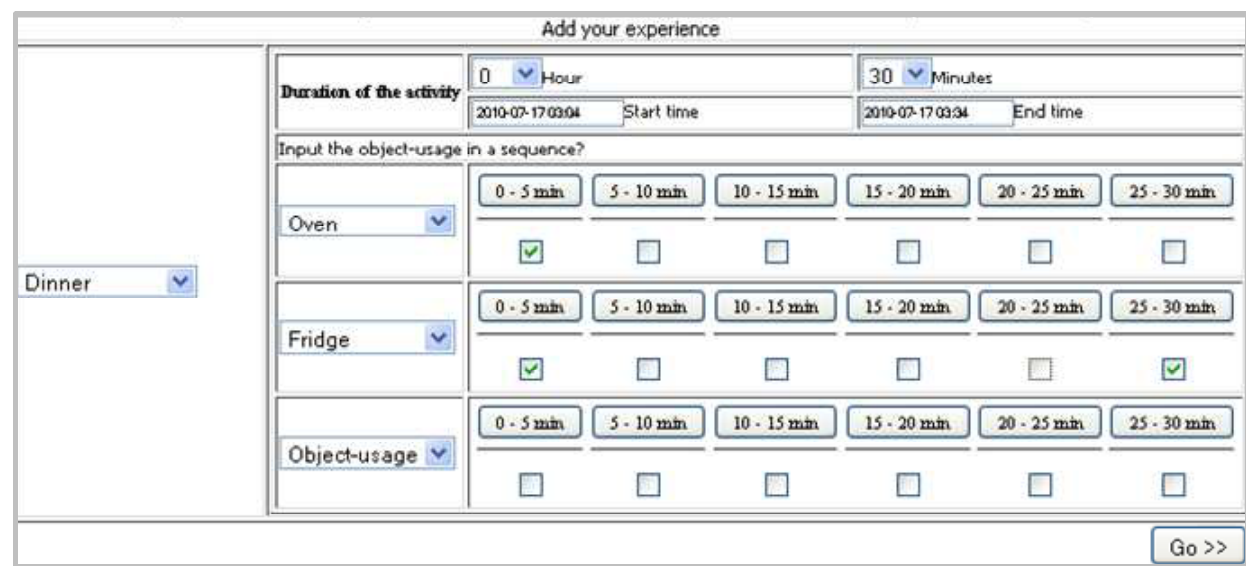
Figure 5. The experience sampling method